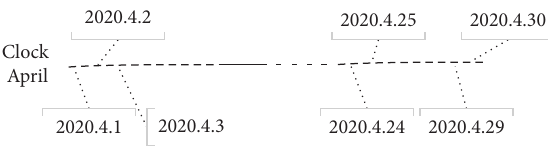
Figure 3: Graphical representation of clock April.